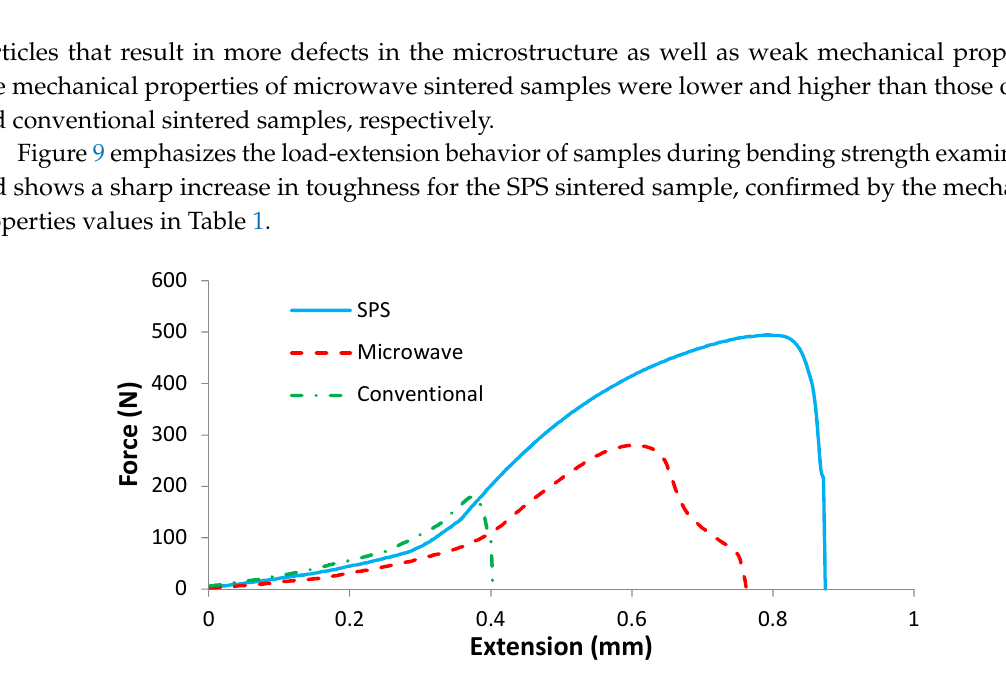
Figure 9. Load-extension curve for SPS, microwave, and conventional sintered samples.